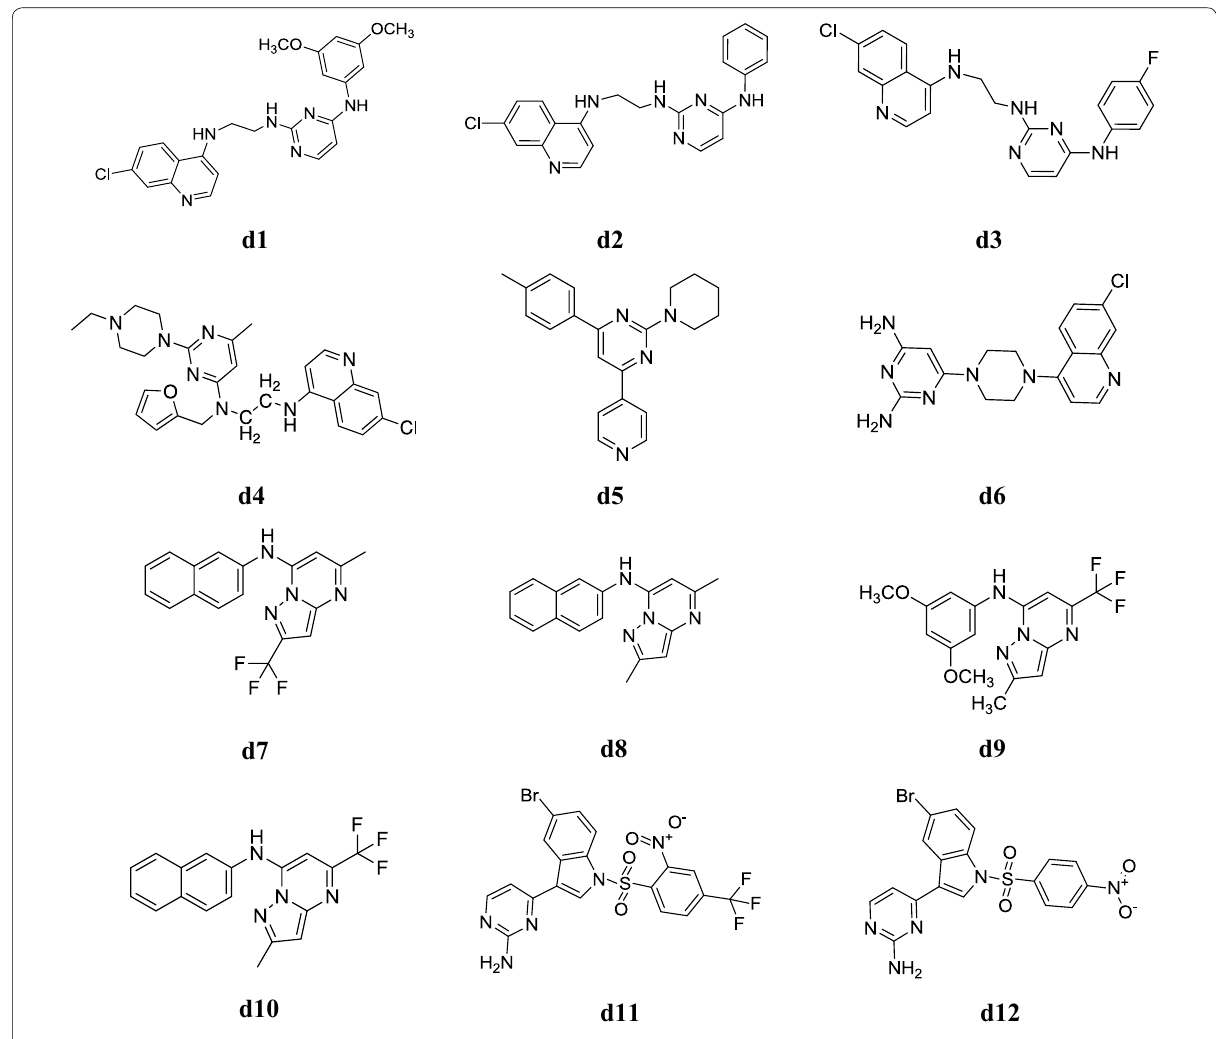
Fig. 9 Chemical structures of the most active antimalarial pyrimidine derivatives ( d1 – d12 )